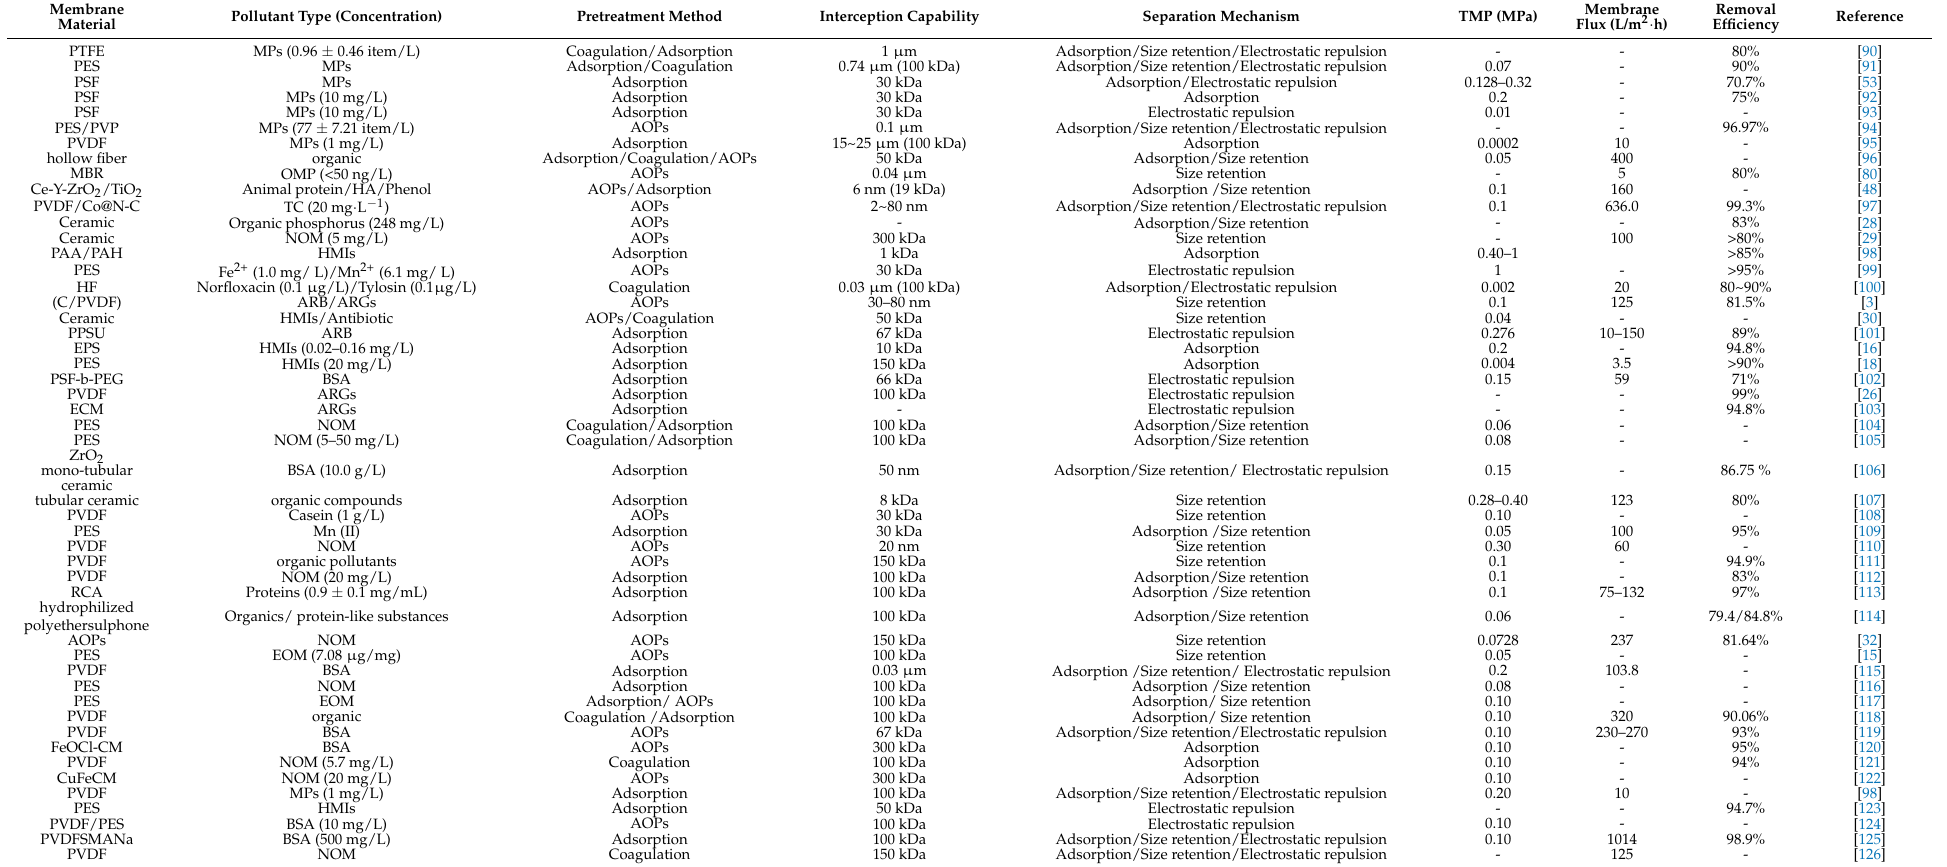
Table 1. Treatment efficiency of pretreatment combined with UF